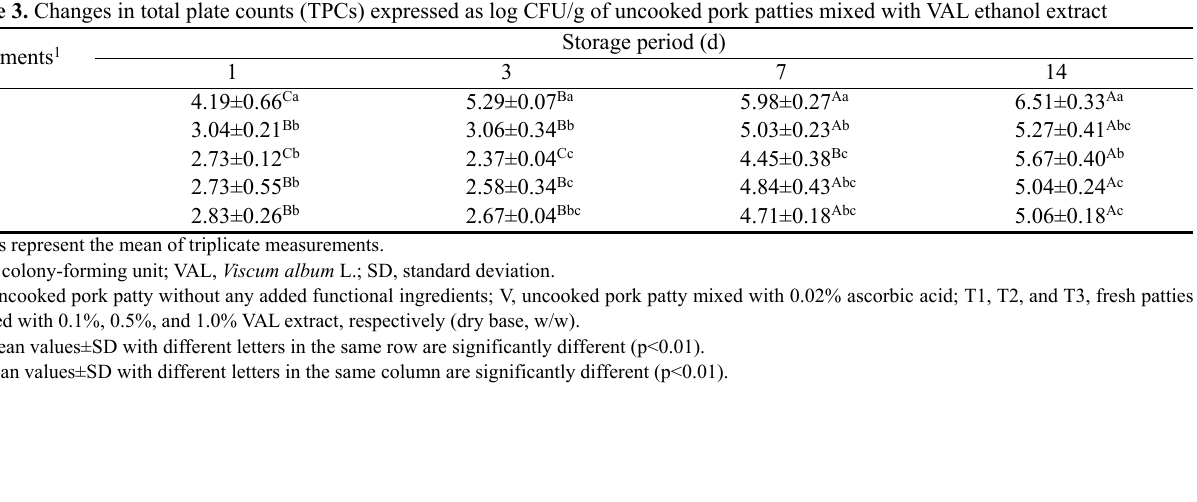
Table 3. Changes in total plate counts (TPCs) expressed as log CFU/g of uncooked pork patties mixed with VAL ethanol extract Treatments 1